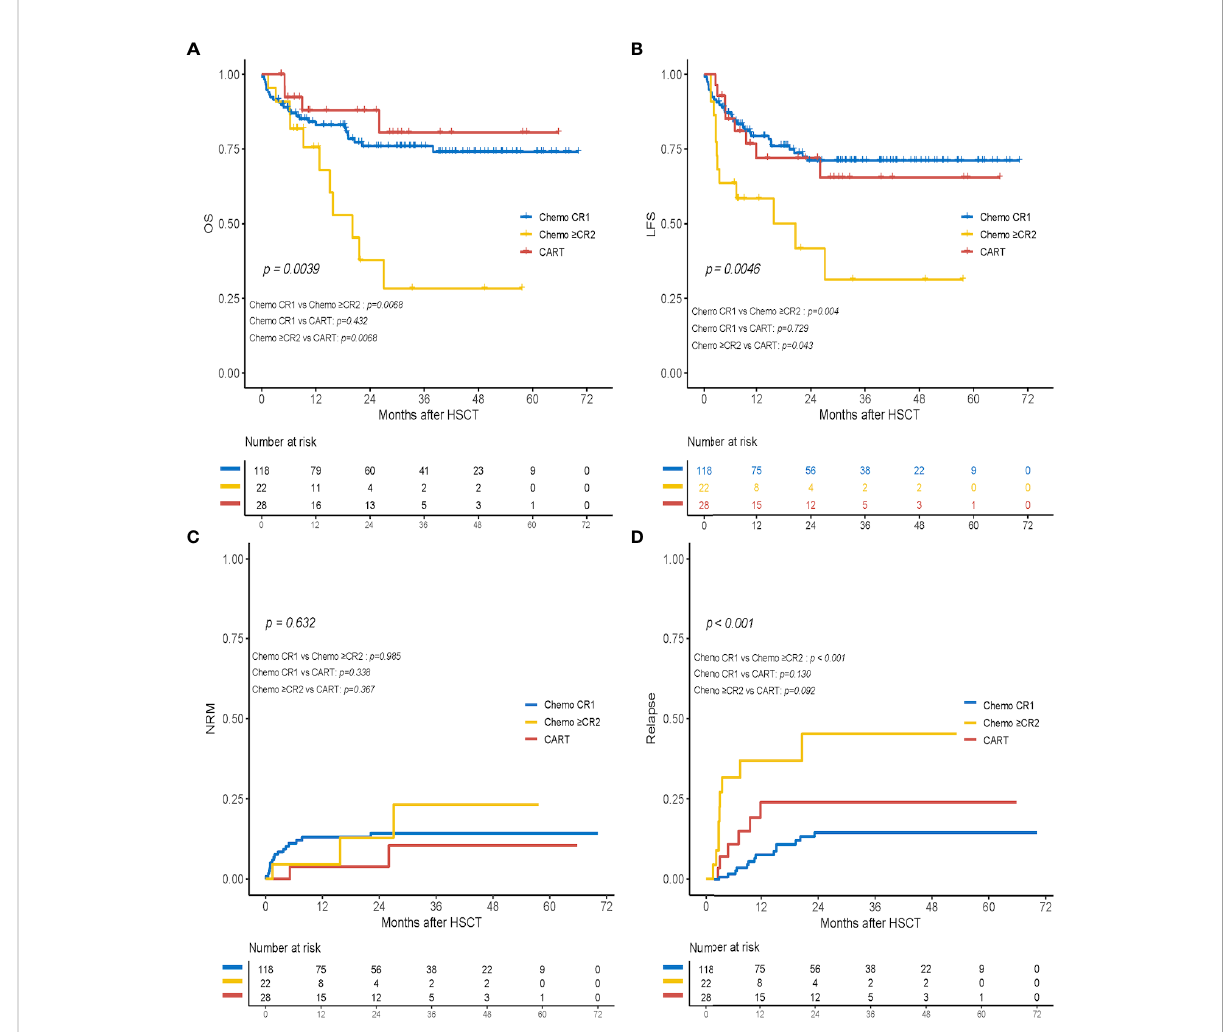
FIGURE 4 Transplant outcomes of subgroup analysis in the chemotherapy+CR1group (chemo+CR1), the chemotherapy+ ≥ CR2 group (chemo+ ≥ CR2) and the CART group. (A) OS; (B) LFS; (C) cumulative incidence of non-relapse mortality (NRM); and (D) cumulative incidence of